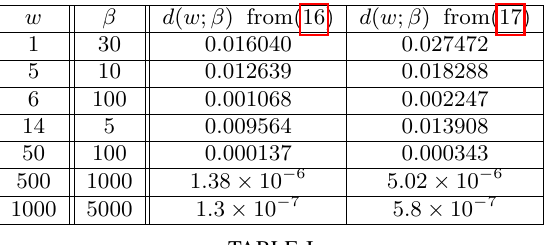
B OUNDS FOR d ( w ; β ) COMPUTED BY (16) AND (17), RESPECTIVELY